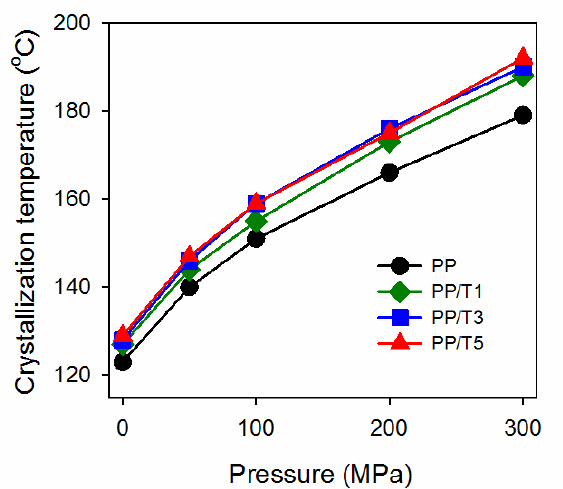
Figure 4. Crystallization temperatures, T c , of neat PP and PP/T nanocomposites crystallized during cooling under various pressures.